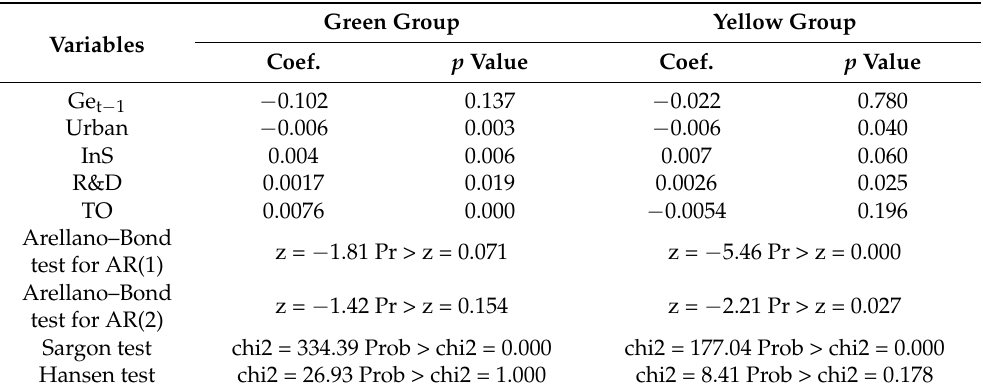
Table 6. The findings of GMM modelling for the analysis of urbanisation impacts on green economic growth among the analysed green and yellow Group countries (dynamic model). Green Group Yellow Group Variables Coef. p Value Coef. p Value Ge t − 1 − 0.102 0.137 − 0.022 0.780 Urban − 0.006